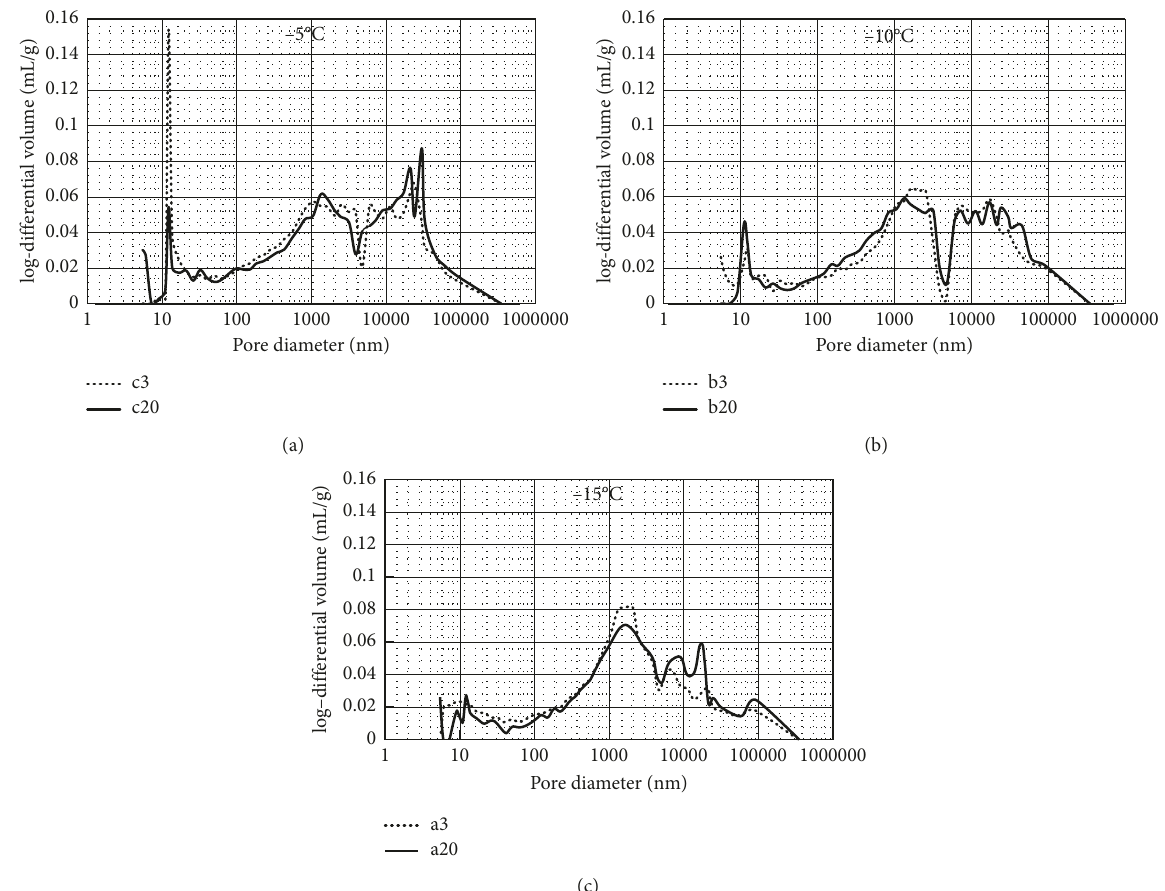
Figure 5: Distribution curves of logarithmic differentiation of soil pore diameters after freeze-thaw cycles at different freezing temperatures: (a) 5 ° C, (b) − Table 5: Statistics of pore data of soil samples. Mean pore diameter Soil sample ID Porosity (%) (4V/A)